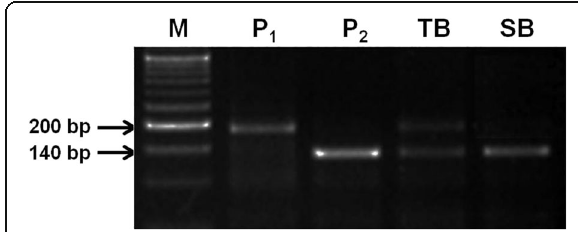
Fig. 3 F 2 population of HTM-N22-/Pusa 1656 tested by BSA with polymorphic SSR marker, RM 6844 in the vicinity of candidate gene, AHAS on Chromosome